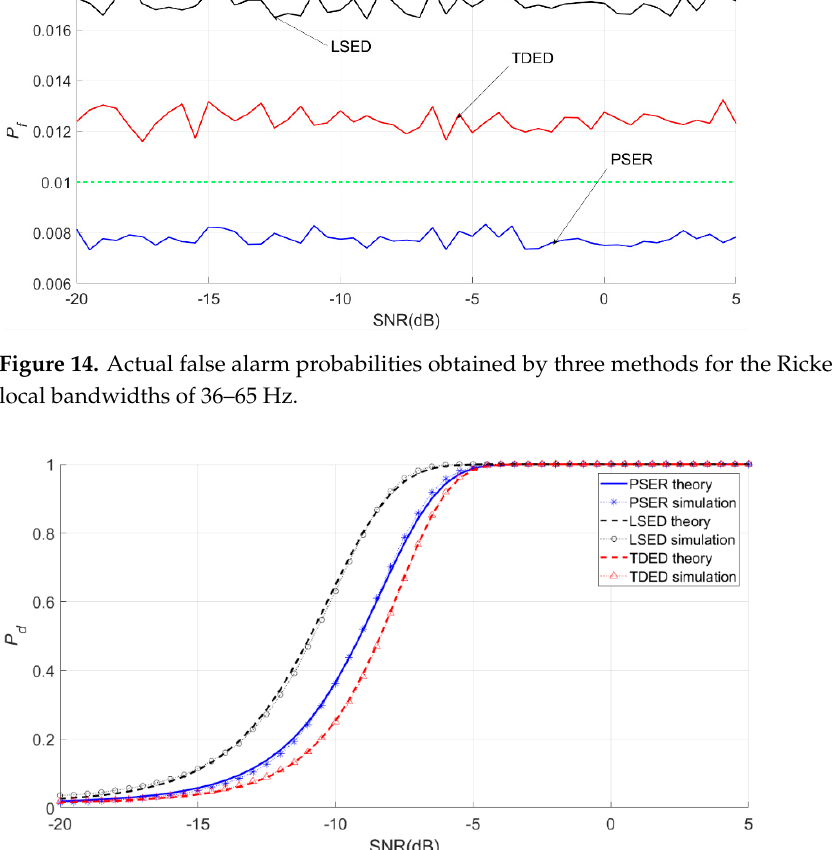
Figure 15. Actual and theoretical detection probabilities obtained by three methods for the Ricker wavelet with local bandwidths of 36–65 Hz.